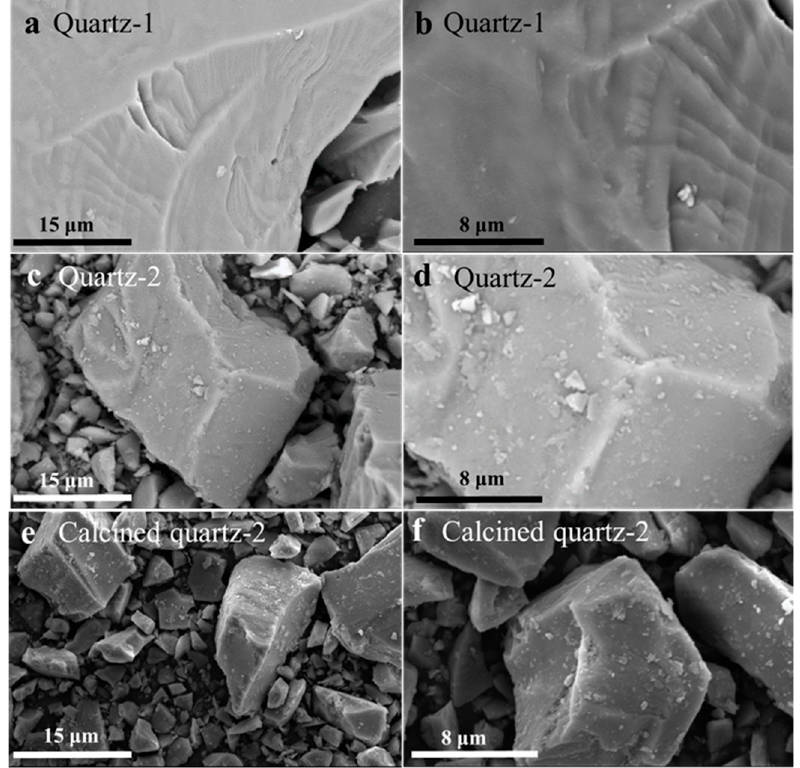
Figure 5. SEM images of ( a , b ) quartz-1, ( c , d ) quartz-2 and ( e , f ) calcined quartz-2.